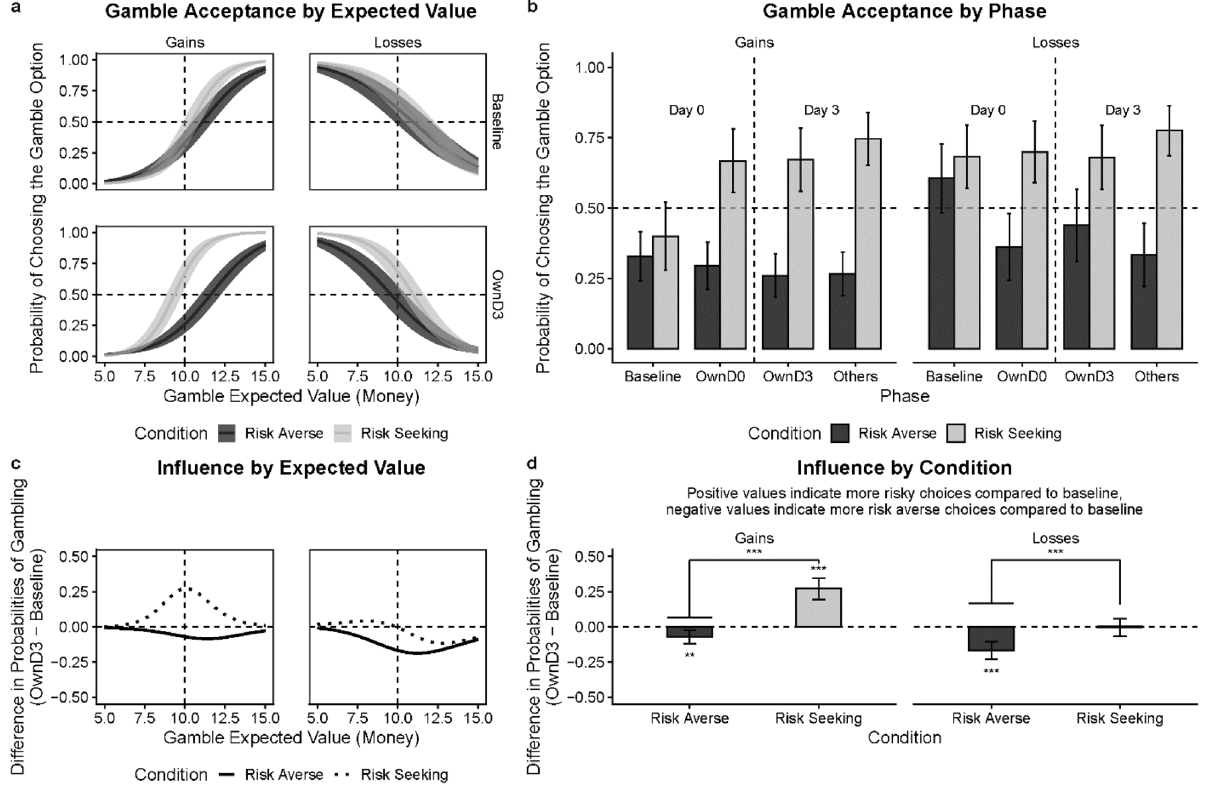
Figure 5. Persistence of conformity in the monetary domain. ( a ) Gamble probabilities as function of expected values in the gain or loss frame by conditions (i.e., risk-averse or risk-seeking ) in the baseline and OwnD3 (own choices) phases. Dashed lines represent equal expected values of the certain and gamble options (vertical), or the equal probability of opting to gamble or not (horizontal). ( b ) Marginal probabilities of accepting the gamble option across phases by conditions. ( c ) Amount of influence as a function of expected values for each condition in the gain or loss frame. ( d ) Marginal amount of influence for each condition in the gain or loss frame. The amount of influence is represented as the mean difference in gamble probability between OwnD3 and baseline phases. Hanging horizontal bars represent absolute magnitude of the difference. Presented are results based on the data collected from individuals who completed the sessions on day 0 (D0) and day 3 (D3). Error bars and confidence bands represent 95% Confidence Intervals (95% CI). * p < .05, ** p < .01, *** p <